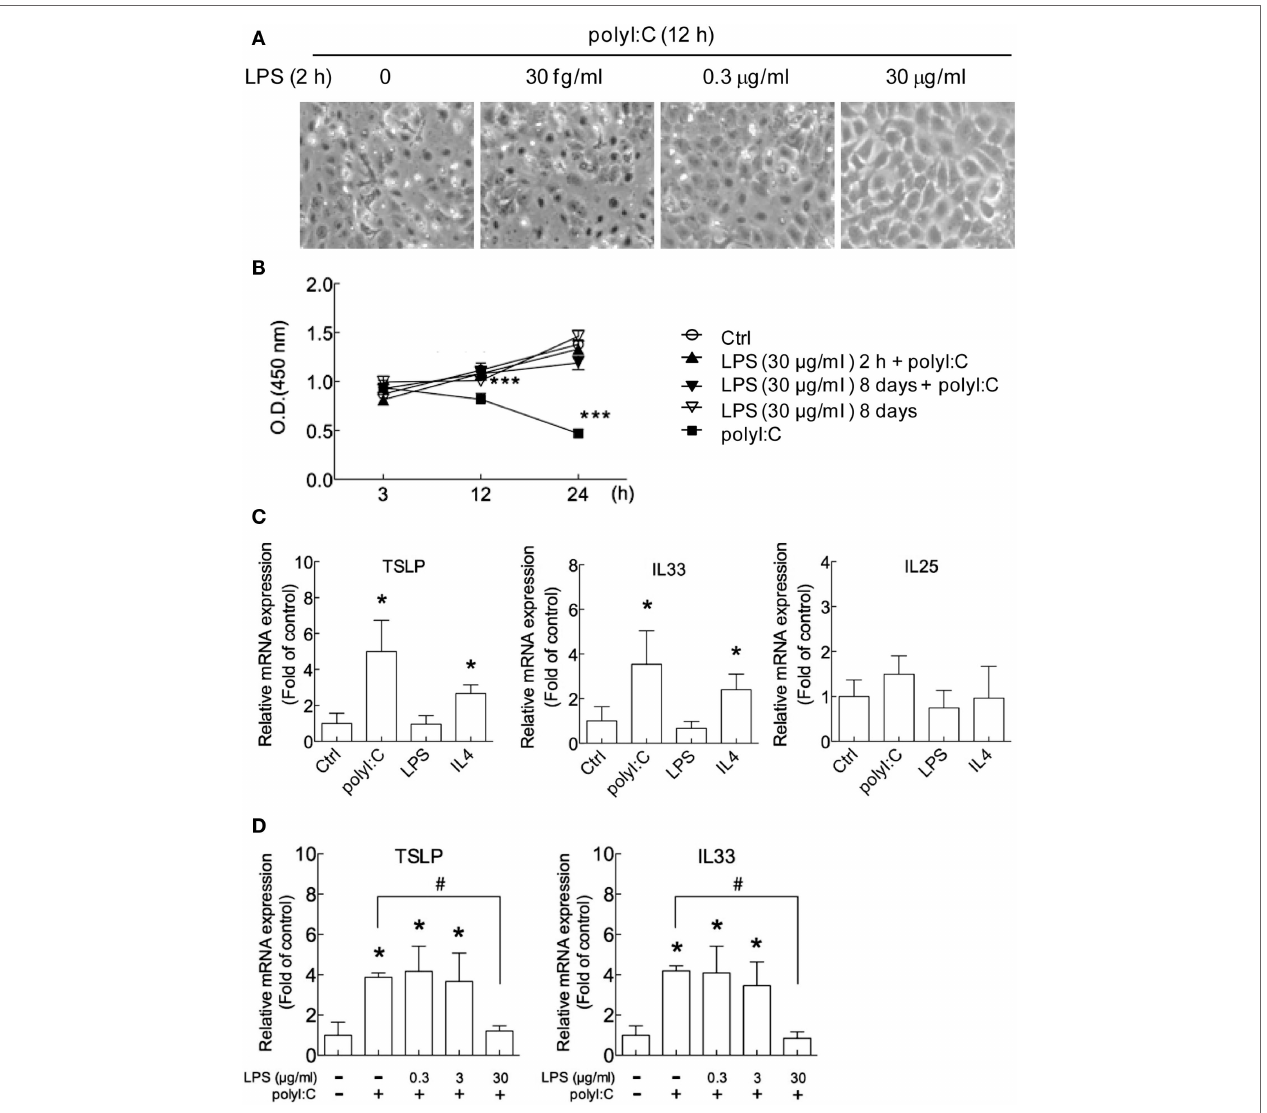
FigUre 1 | Polyi:c-induced cell damage and allergic cytokine expression are attenuated by lipopolysaccharide (lPs) in airway epithelial cells . (a) H292 cells were treated with LPS (3 × 10 − 8 , 0.3 and 30 μ g/ml) for 2 h followed by polyI:C (2.5 μ g) transfection for 12 h. Representative images from three independent experiments show that cell morphology under an inverted microscope. (B) H292 cells were treated with control medium (Ctrl) or 30 μ g/ml LPS for 2 h or 8 days then stimulated with polyI:C (100 ng) for 3, 12, or 24 h. Cell viability was analyzed by WST-1 assay. Results are representative of three independent experiments. (c) H292 cells were treated with polyI:C (2.5 μ g), LPS (30 μ g/ml), or IL4 (20 ng/ml) for 3 h, and thymic stromal lymphopoietin (TSLP), interleukin 33 (IL33) and IL25 mRNA expression was analyzed by RT-qPCR. (D) H292 cells were pretreated with LPS (0, 0.3, or 30 μ g/ml) for 2 h, then stimulated with polyI:C